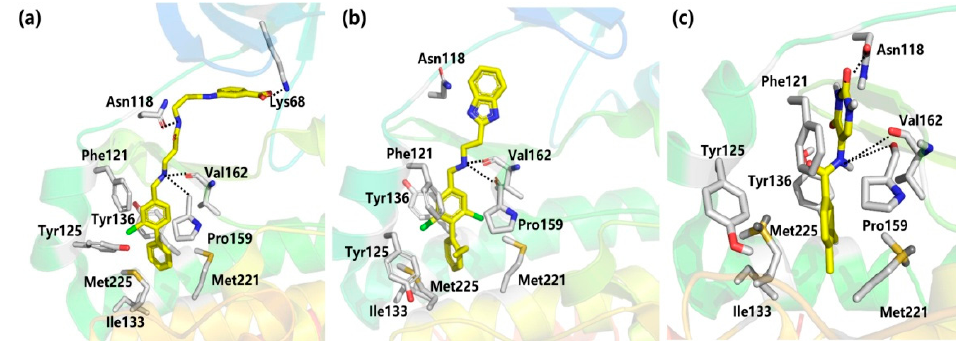
Figure 5. Interaction modes of compounds ( a ) 9 (CAM4066), ( b ) 10 (CAM4712) and ( c ) 11 with α D pocket.